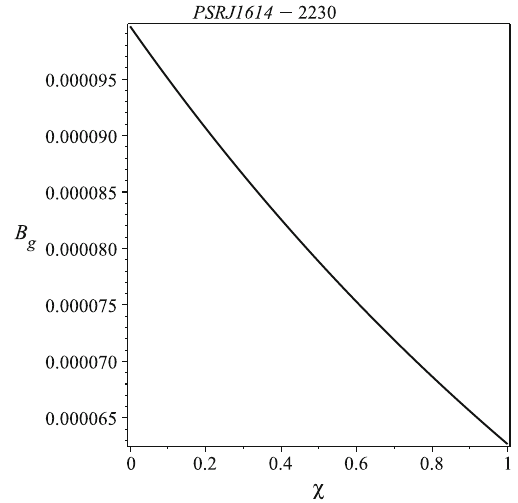
Fig. 2 Variation of B g w.r.t. χ for the strange star candidate PSRJ